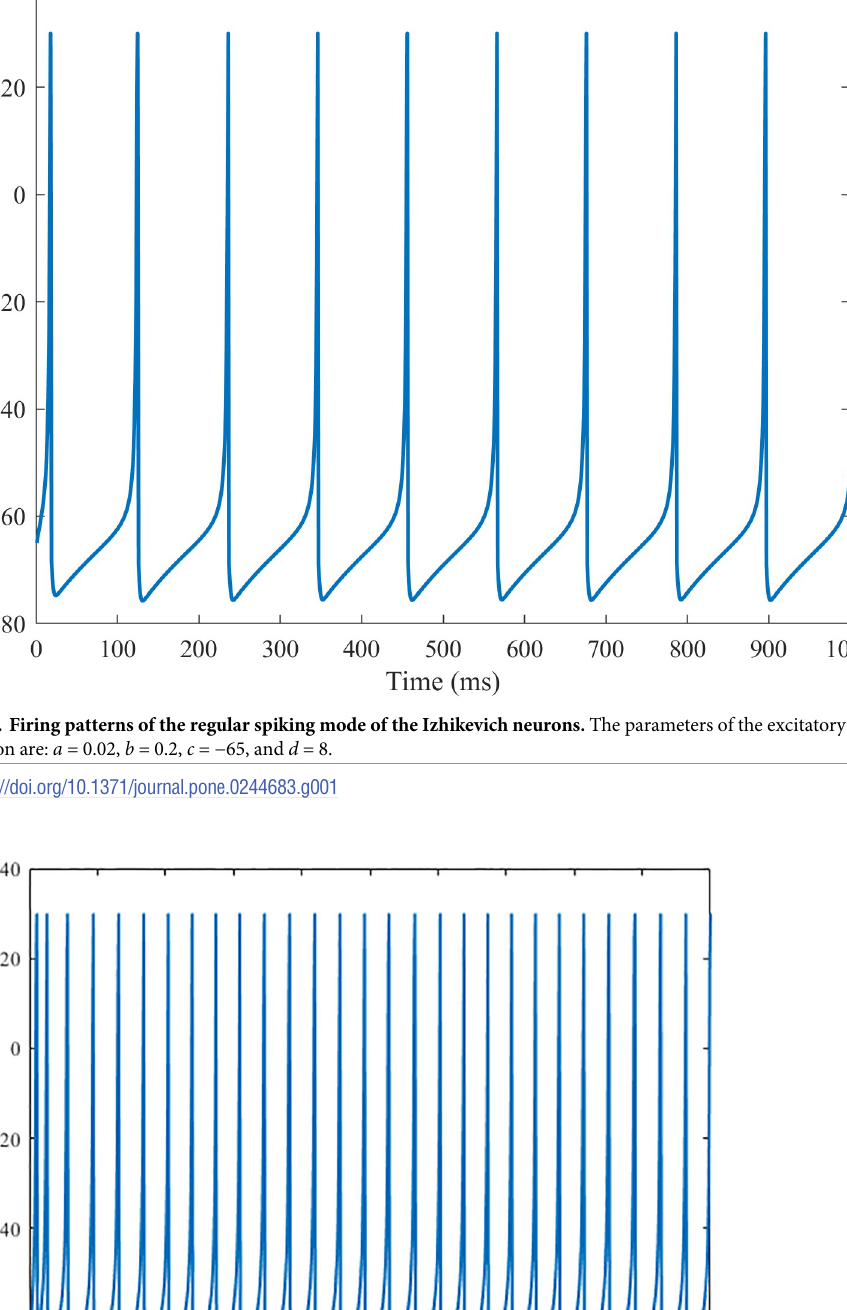
PLOS ONE | https://doi.org/10.1371/journal.pone.0244683 December31,